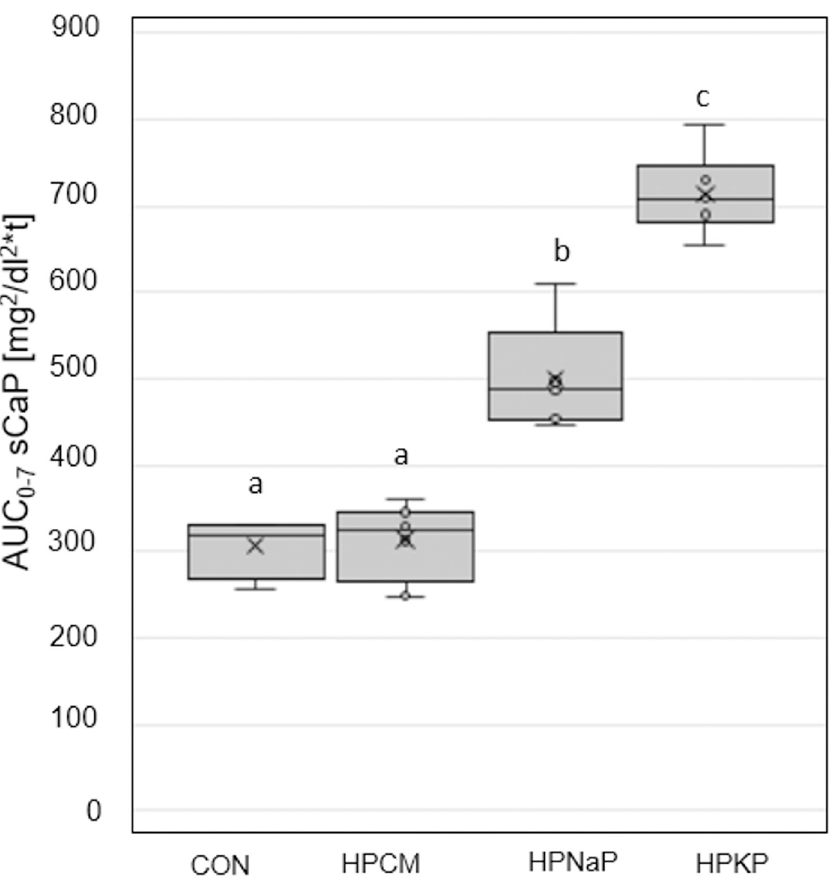
Fig 2. AUC 0-7 of sCaP [mg 2 /dl 2 � t] in adult dogs fed a control and 3 high P diets for 18 days. Boxes not sharing a superscript letter are significantly different (p < 0.05).